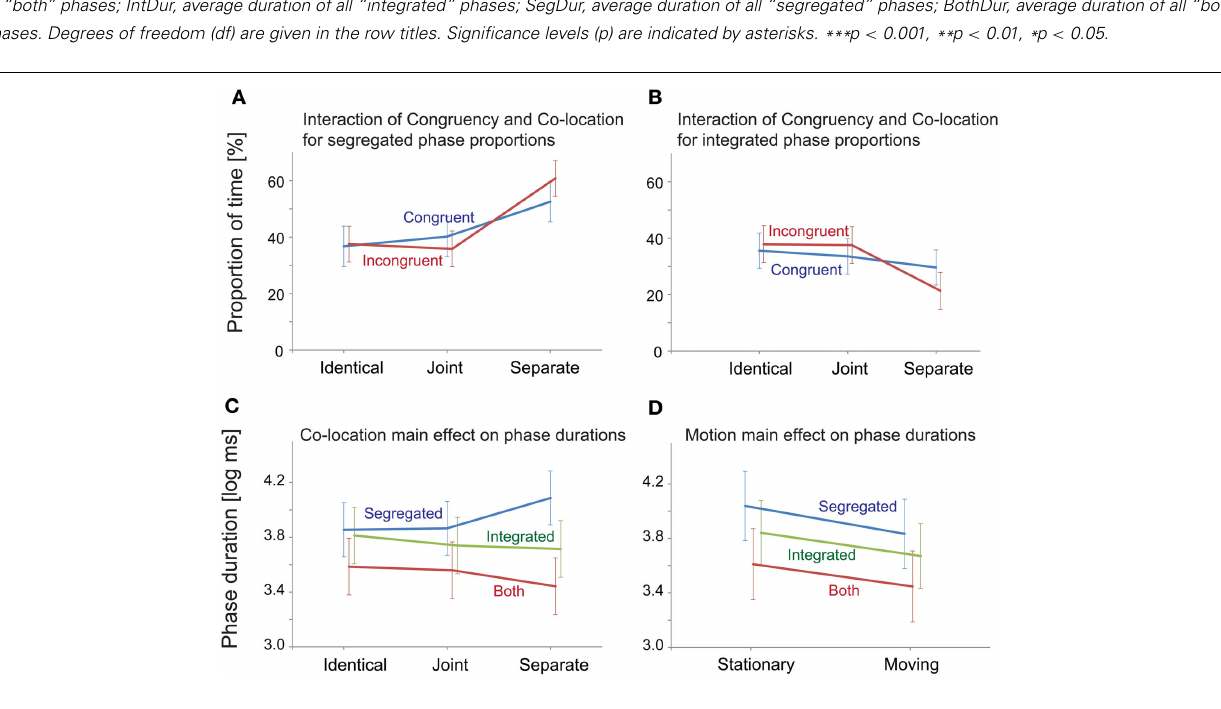
Incongruent visual cues. (C) Spatial separation influenced the average phase durations for all percepts, this effect being significant only for the “segregated” phases. (D) Motion had a significant main effect on the log-mean phase durations of all percepts. In all panels, error bars show the standard errors of